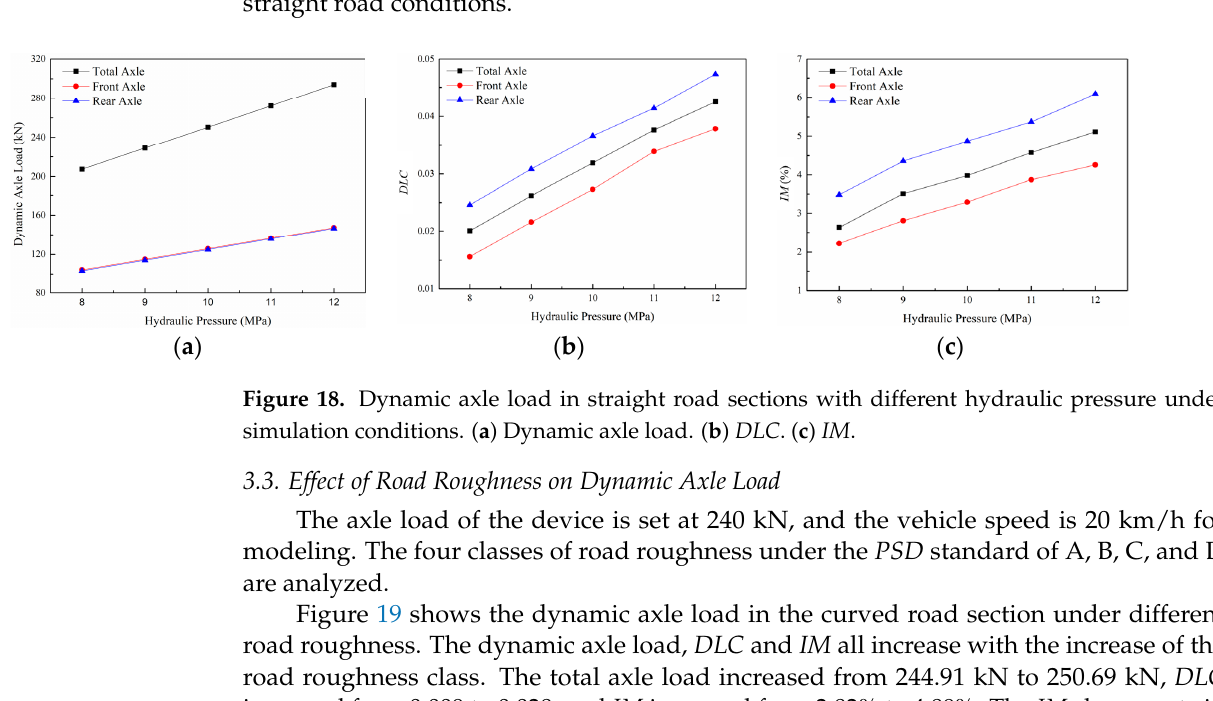
( c ) Figure 17. Dynamic axle load in curved road sections with di ff erent hydraulic pressure under sim- ulation conditions. ( a ) Dynamic axle load. ( b ) DLC . ( c ) IM . It can be seen from the fi gure that the dynamic axle load, DLC and IM all increase with the increase of the hydraulic pressure. The total axle load increased from 202.37 kN to 287.87 kN, DLC increased from − 0.005 to 0.021, and IM increased from 0.96% to 3.65%. As mentioned above, because the device is a ff ected by the vibration of the device in the curved road section, the force of the hydraulic cylinder in the running state is not as high as that under static conditions, so the dynamic axle load of the device under the condition